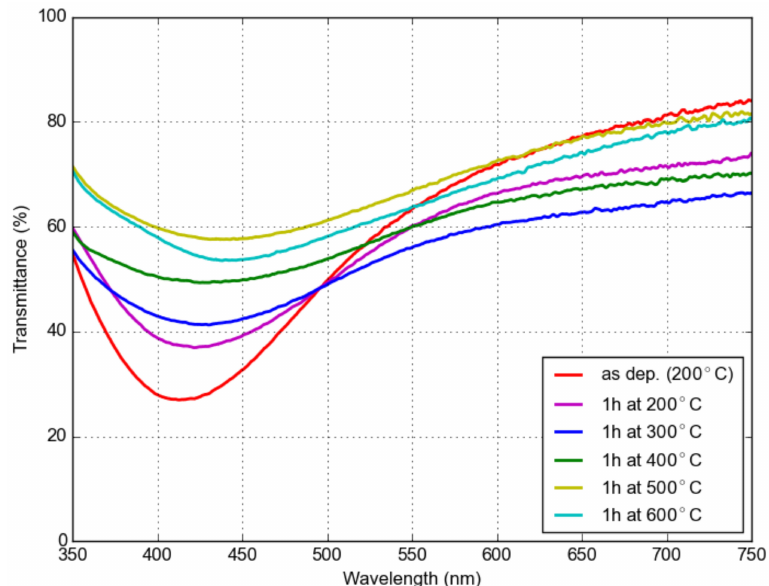
Figure 10. Transmittance of a layer of LaF 3 doped with 7 at.% Yb 3+ and 1 at.% Er 3+ with dispersed Ag nanoparticles on a fused silica substrate annealed at various temperatures.